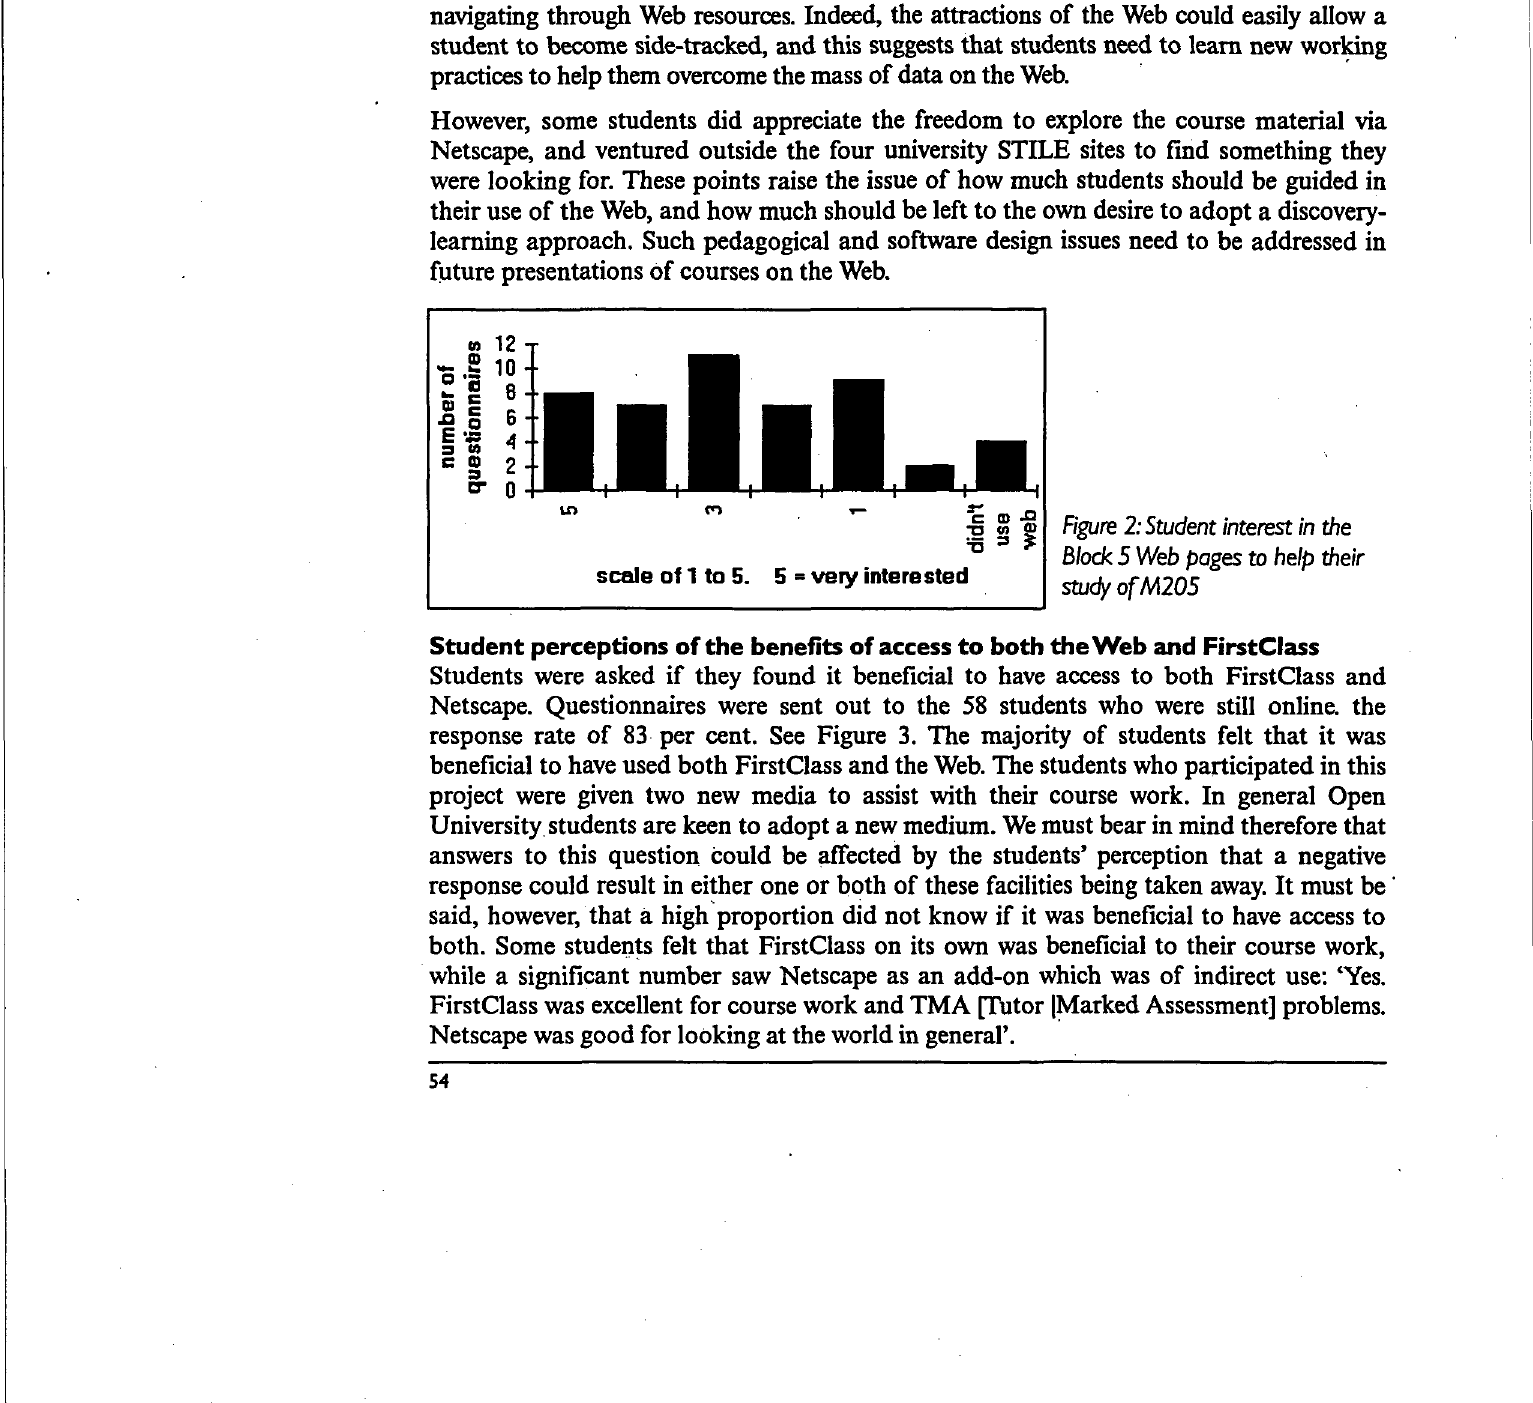
Figure 2: Student interest in the Block 5 Web pages to help their study